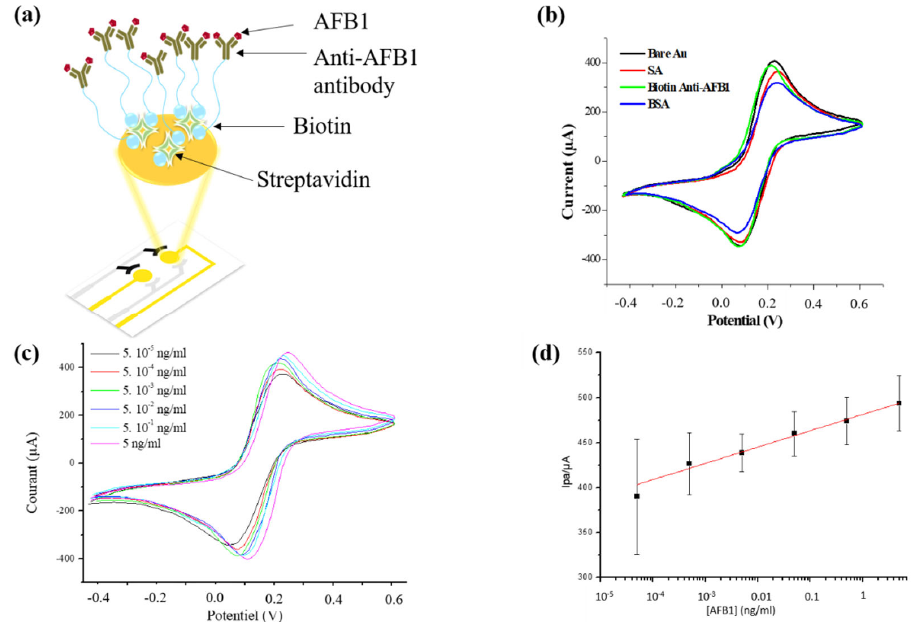
Figure 9. ( a ) Best functionalization protocol of the working electrode; ( b ) CV diagrams at each func- tionalization step (using the Fe 3+ /Fe 2+ redox couple and a scan rate of 100 mV/s); ( c ) CV diagrams, with the same redox couple, obtained at increasing AFB1 concentrations within a concentration range between 50 fg/mL and 5 ng/mL (scan rate of 100 mV/s); ( d ) Linear response of the sensor in terms of I pa values in this range of concentrations [51].